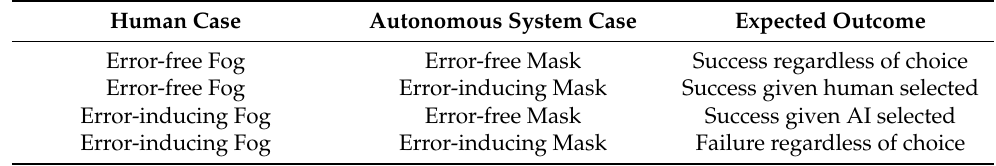
Table 5. Human–AI pair